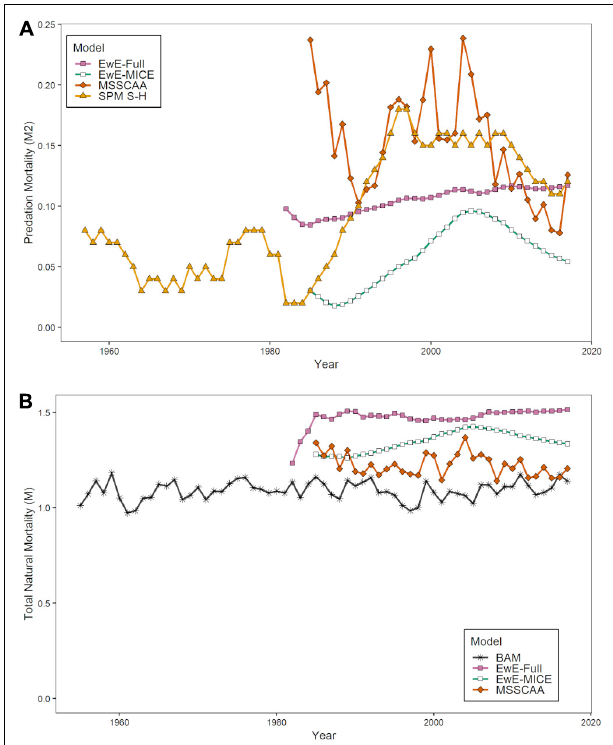
FIGURE 3 | Estimates of biomass-weighted predation mortality M 2 (A) and total natural mortality, M (B) for age-1+ Atlantic menhaden from the ERP models. (B) Includes the biomass-weighted average M for age-1+ Atlantic menhaden used in the single-species assessment.